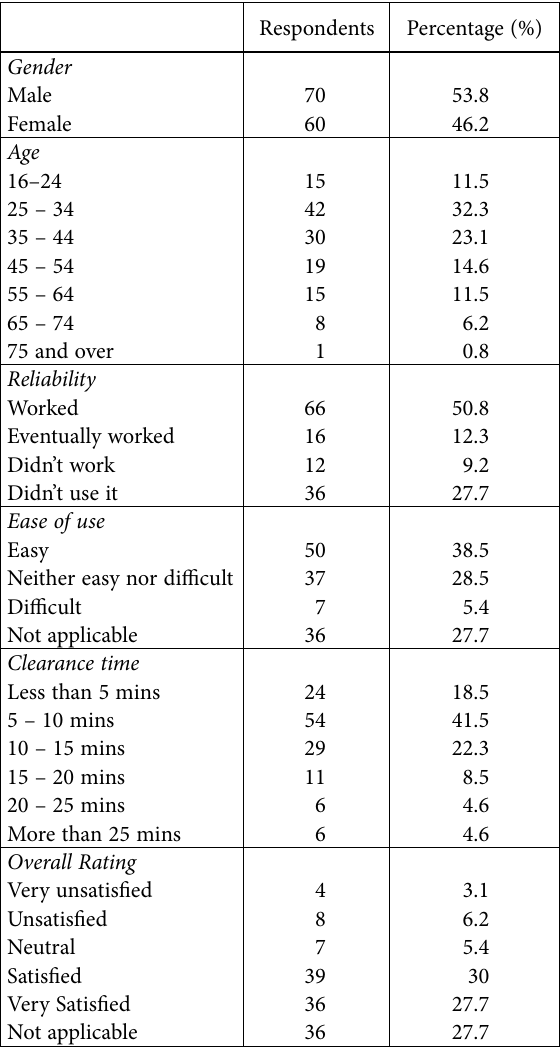
Table 1. Statistical summary of